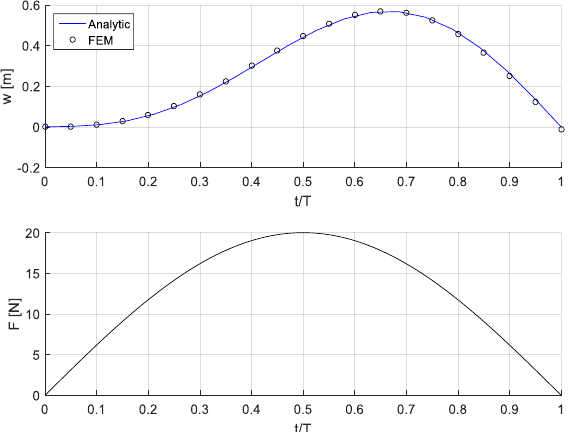
Figure 4. Static response for non-prismatic beams and comparison with data from [51]. The transverse displacement is presented as a function of beam length in the upper subplots for two values of taper ratio. The corresponding normalized beam profiles are shown in the lower subplots, where the maximum thickness is 0.25 m. ( a ) Deflection and ( b ) shape of variable thickness beam. ( c ) Deflection and ( d ) shape of beam with linear thickness distribution.